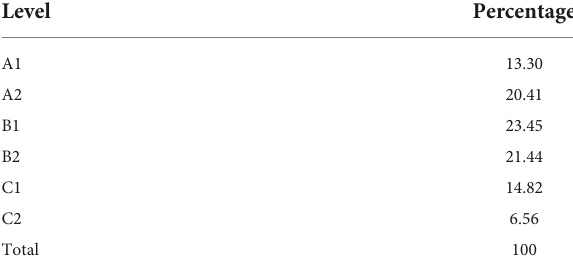
TABLE 2 Evaluation of communication and collaboration area.